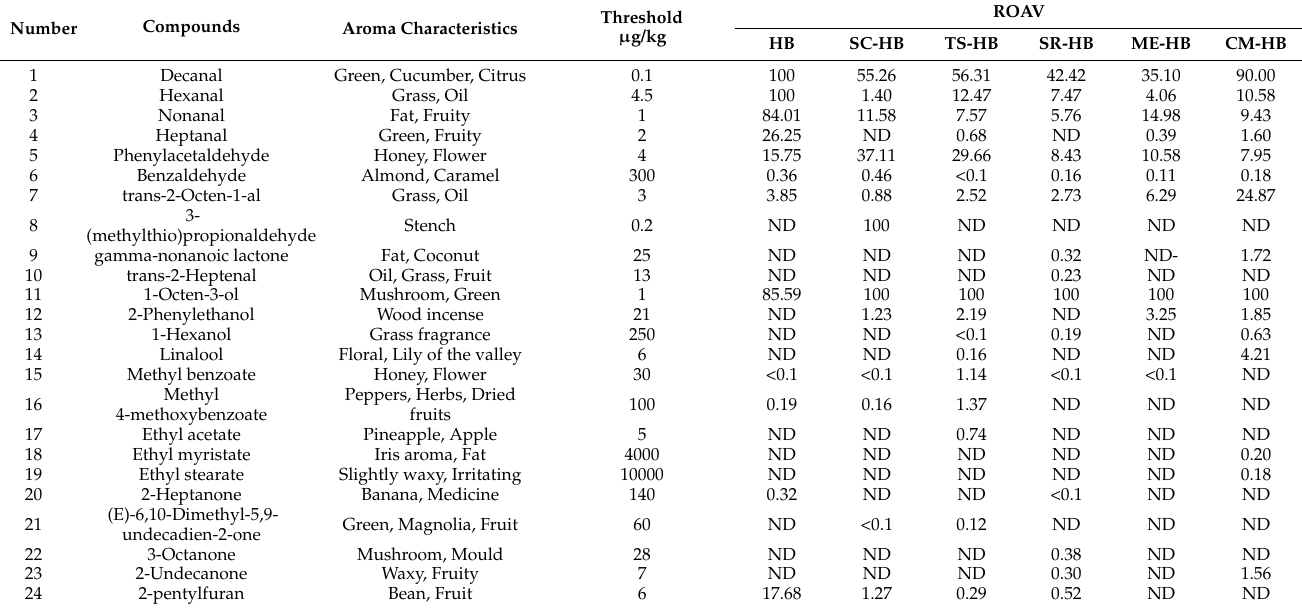
Table 3. ROAV of volatile compounds in original and fermented highland barley